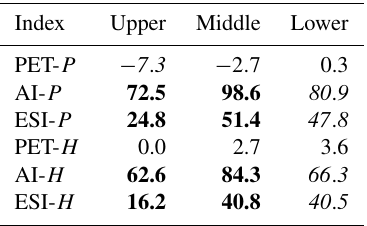
Table 4. Mann–Kendall trends from 1980 to 2010 of potential evap- otranspiration, aridity index, and evaporative stress index (in %). P(H) indicates the Penman–Monteith (Hamon) method. The bold and italic numbers are significant at p <0.01 and p